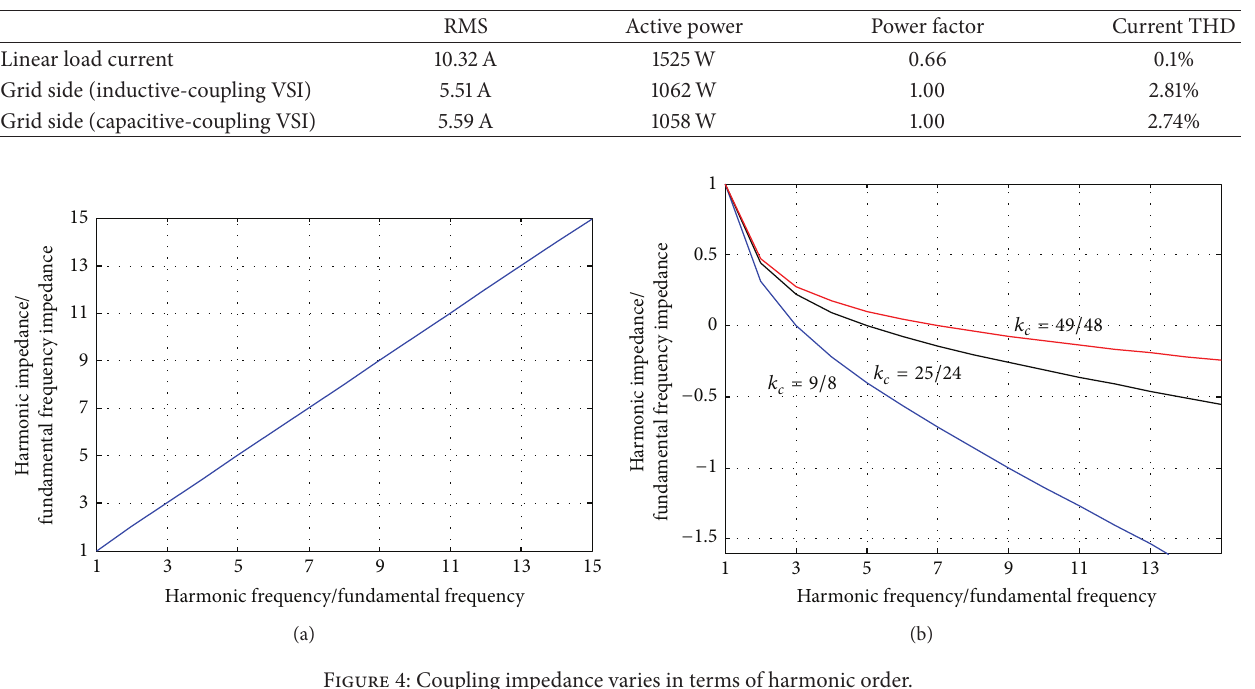
Figure 4: Coupling impedance varies in terms of harmonic